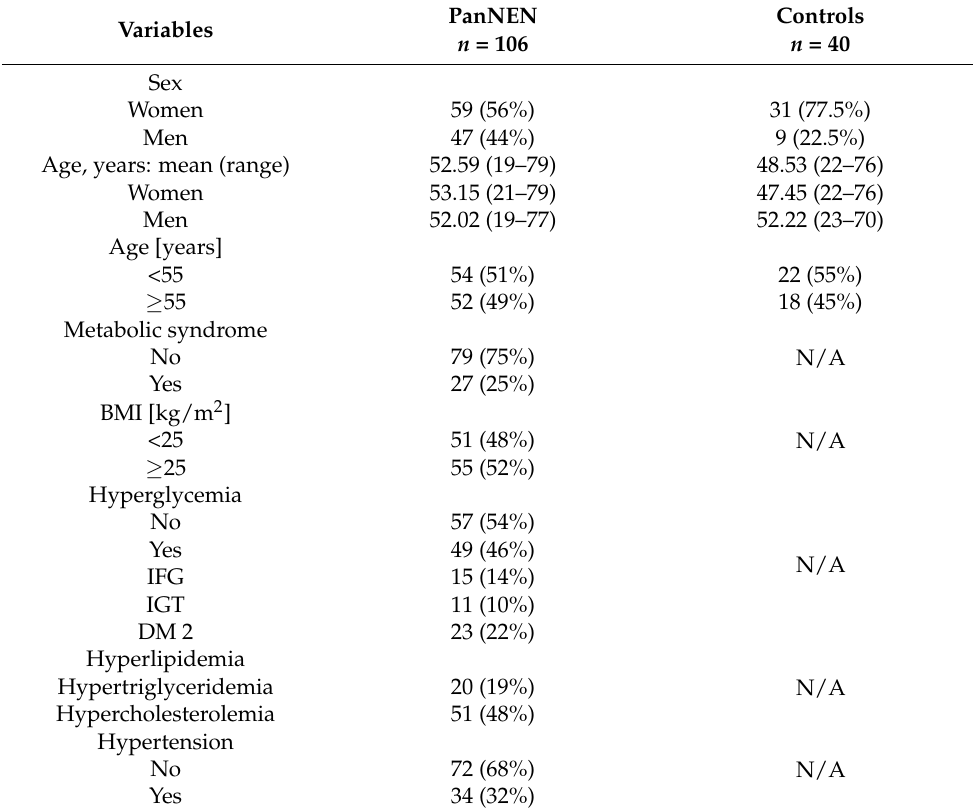
Table 1. Demographic, clinical, metabolic, and laboratory characteristics of patients with pancreatic neuroendocrine neoplasm (PanNEN) and controls were included in the study.